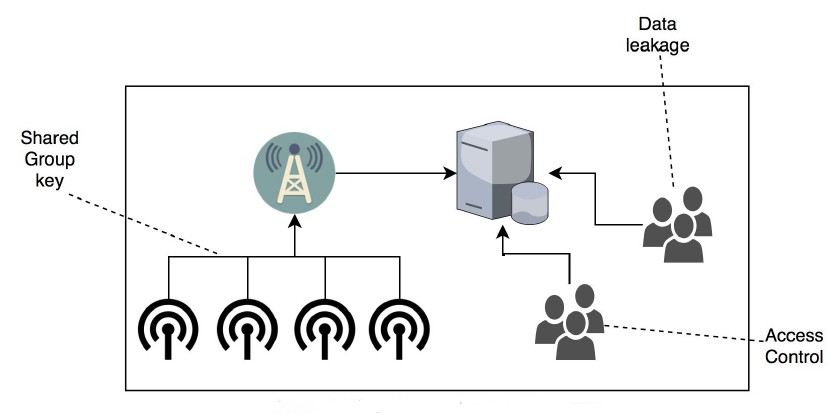
Figure 1. High level security vulnerabilities in static WSNs.